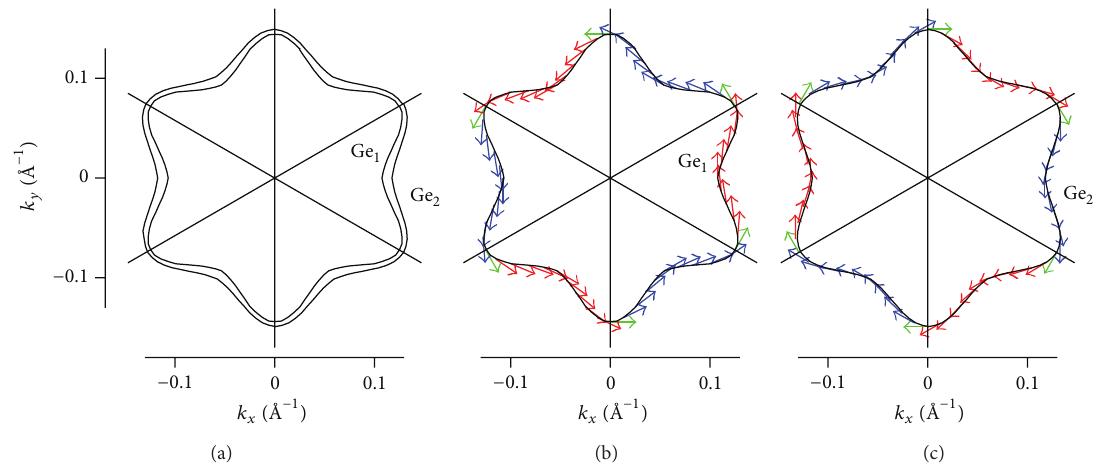
Figure 6: (a) Constant-energy contours at 110meV above the theoretical Fermi energy for the hole-like bands of Ge character. The labels Ge 1 and Ge 2 correspond to the inner and outer contour, respectively. ((b) and (c)) Spin patterns along the inner and outer